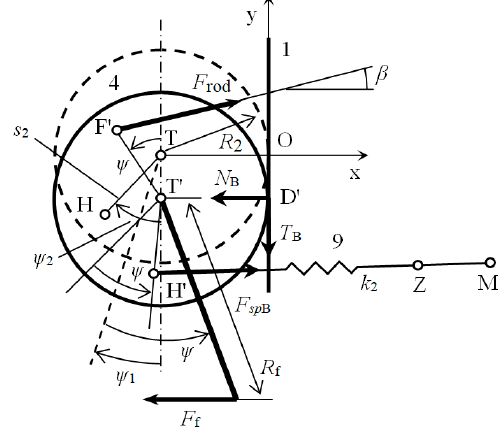
Figure 5. Freebody diagram—roller (4).